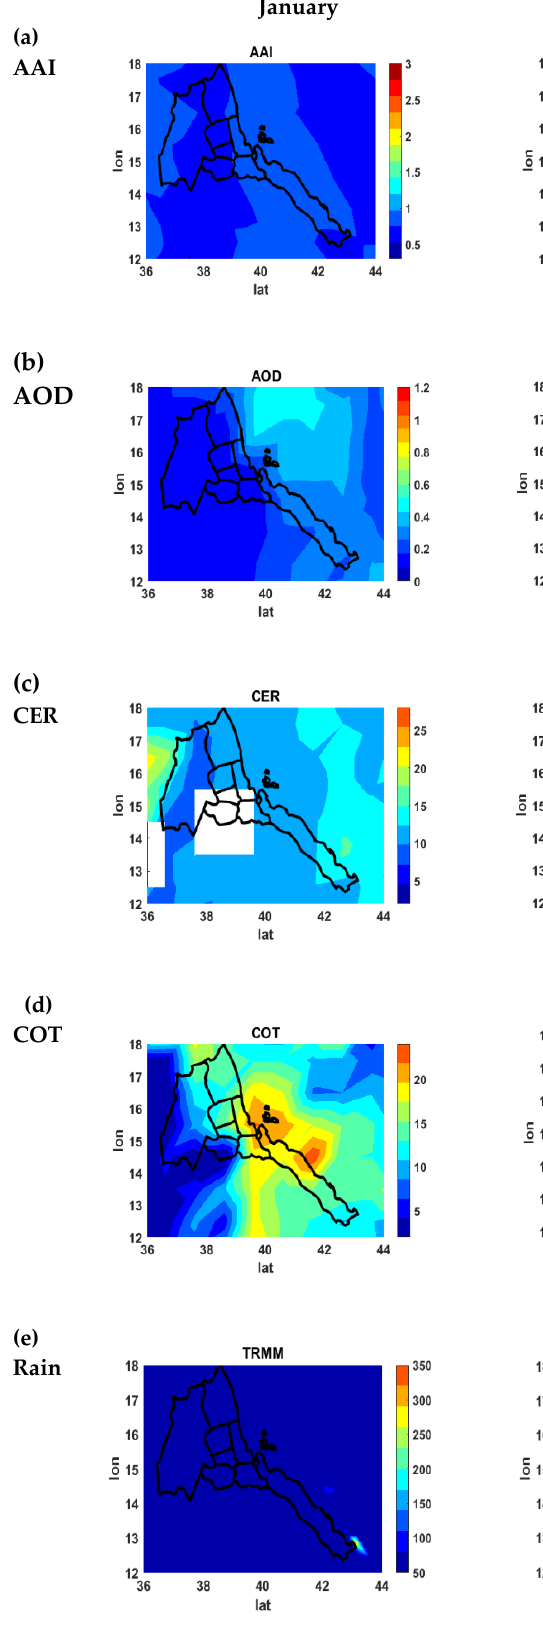
Figure 5. ( a ) AAI, ( b ) AOD, ( c ) CER (µm), ( d ) COT, and ( e ) rainfall (mm) in January, April, and October 2007 for compar- ison.